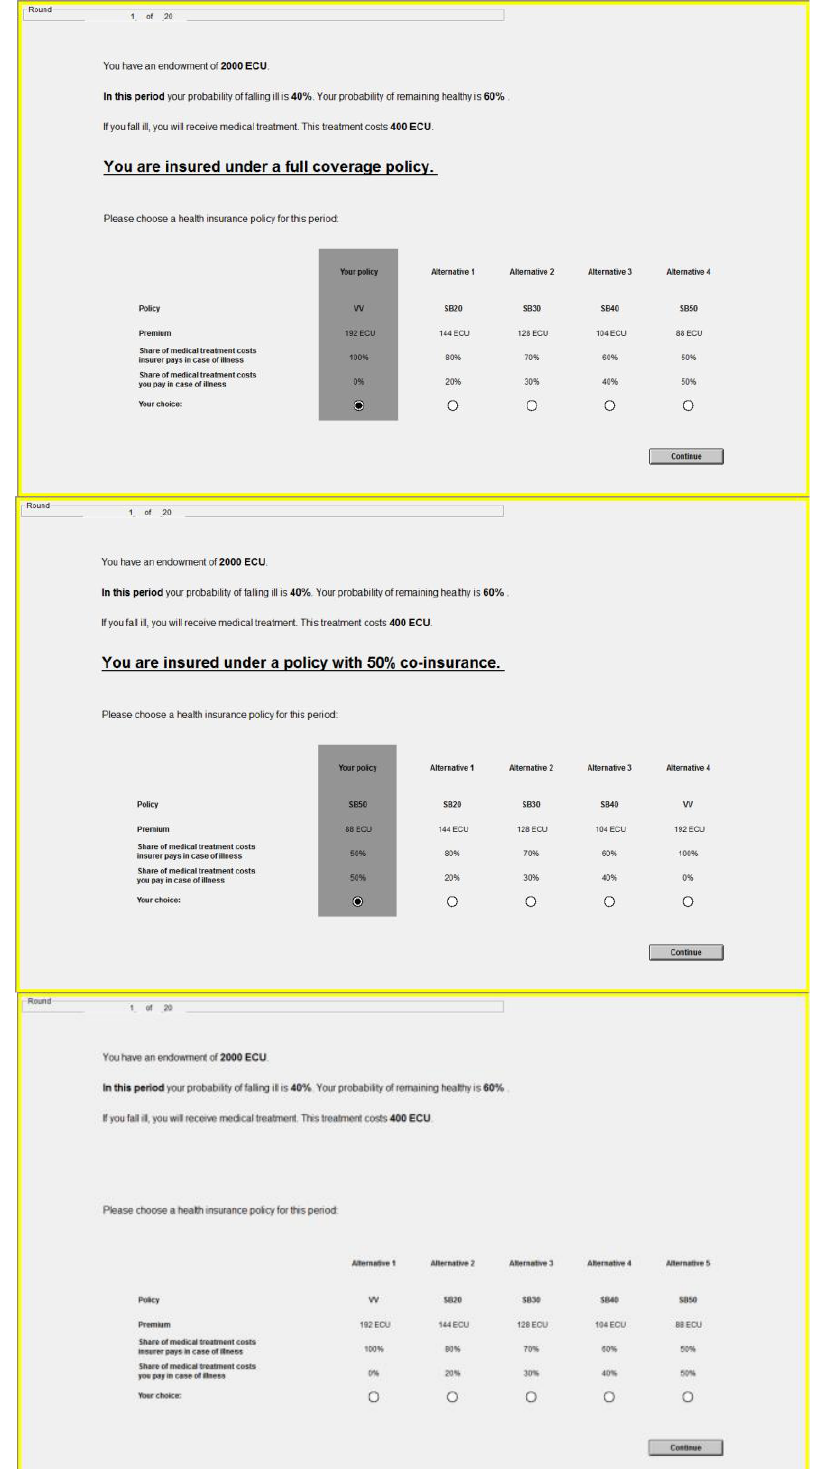
Figure 3. The decision situation for groups FULL, SHARE, BASELINE (top to